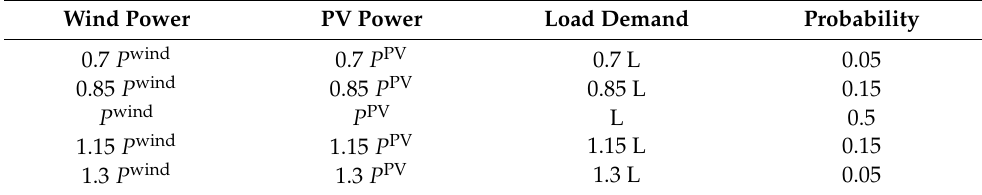
Table 4. Probability of PV power, wind power, and load demand.